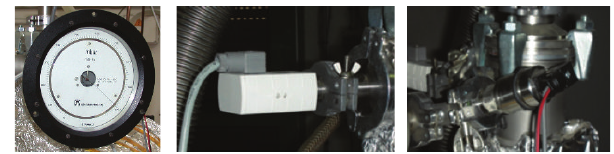
Figure 9: From the left: barometer; Pirani; BOC Edwards